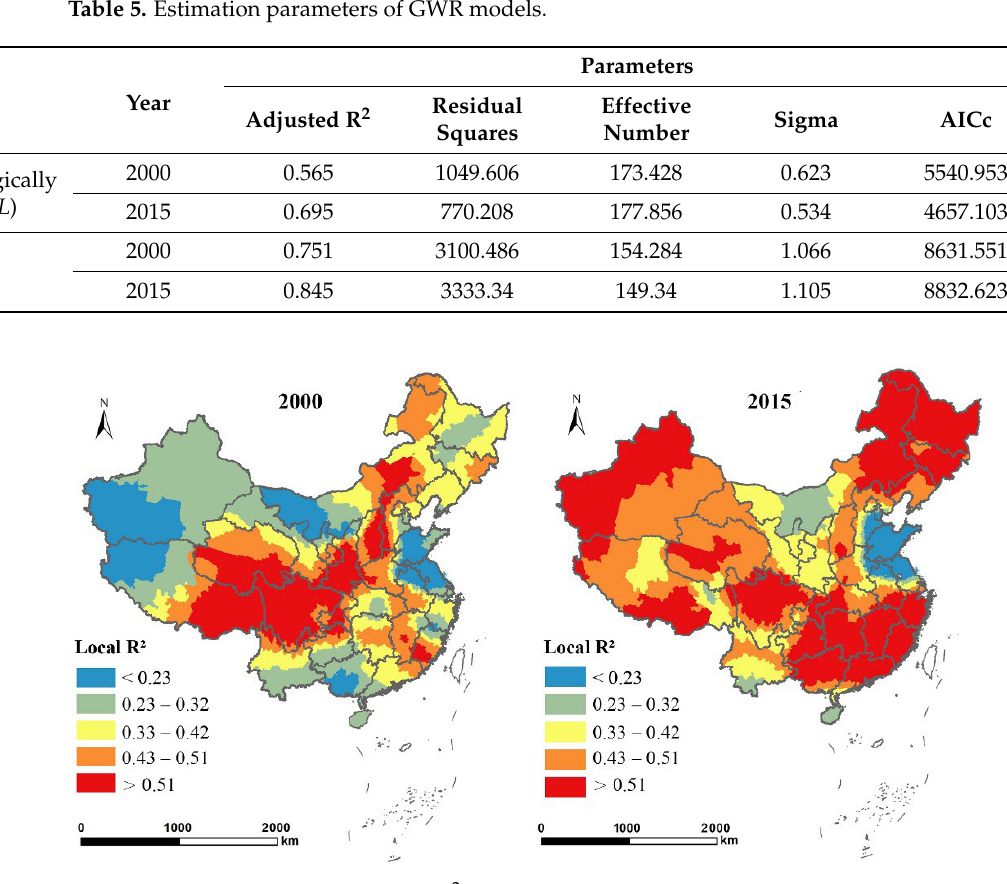
Figure 4. Spatial distribution of local R 2 in the GWR model with the proportion of EFL (ln EL ) as the dependent variable in 2000 and 2015.